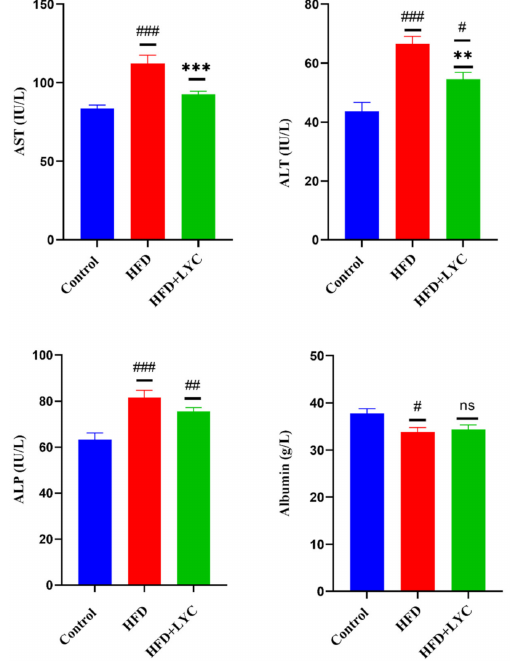
Figure 1. Serum levels of liver function biomarkers AST, ALT, ALP, and albumin following treatment with LYC in rats fed an HFD. Data are expressed as the mean ± SEM of two replica ( n = 12 rats). Different markers correspond to statistically significant differences between groups. # p < 0.05, ## p < 0.01, and ### p < 0.001 indicate significant, highly significant, and very highly significant compared with the control, respectively. ** p < 0.05 and *** p < 0.001 indicate a highly significant and a very highly significant difference compared to the HFD group, respectively. ns: